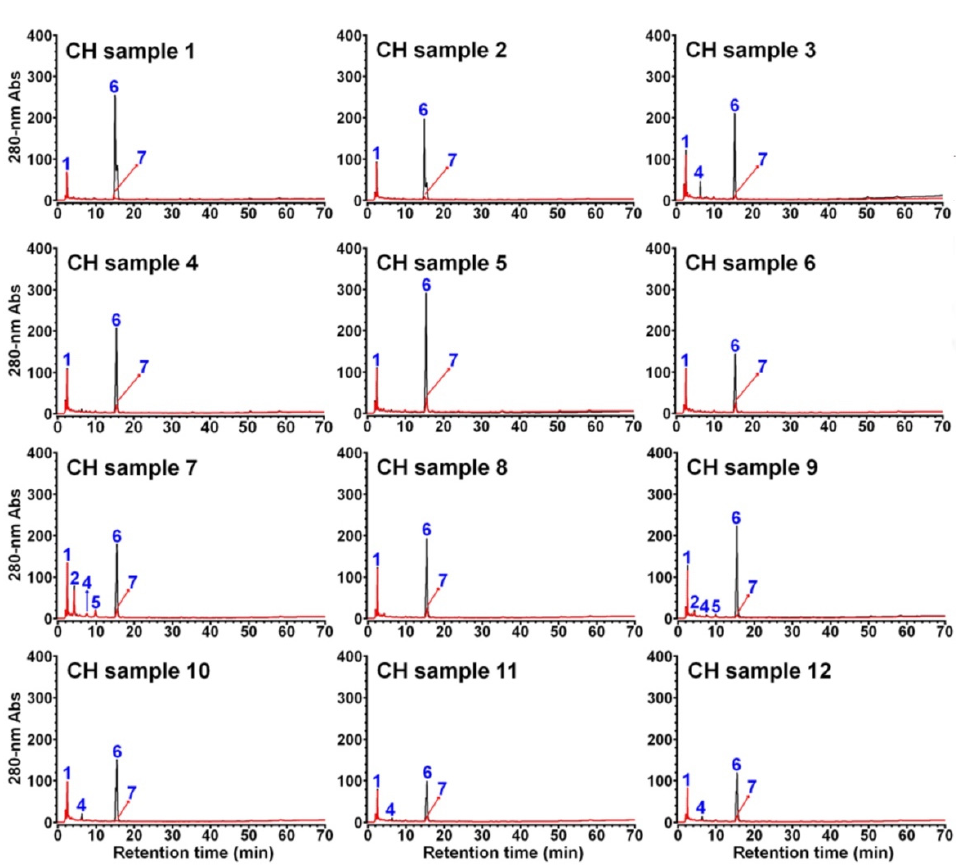
Figure 10. HPLC analysis of aqueous extract of 12 different CH samples. The chromatograms in black and in red were obtained based on a direct injection of the samples without (or before) and with (or after) CHCl 3 treatment, respectively. Table 4. Quantification and distribution of the 6 CH compounds (mg/g).